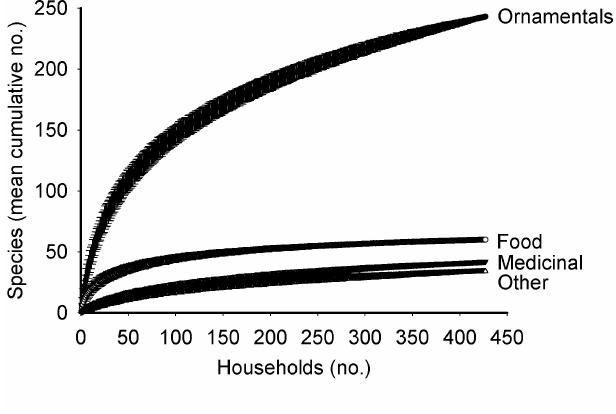
Table 1 . Chi-squared test of heterogeneity to evaluate differences in plant origin.